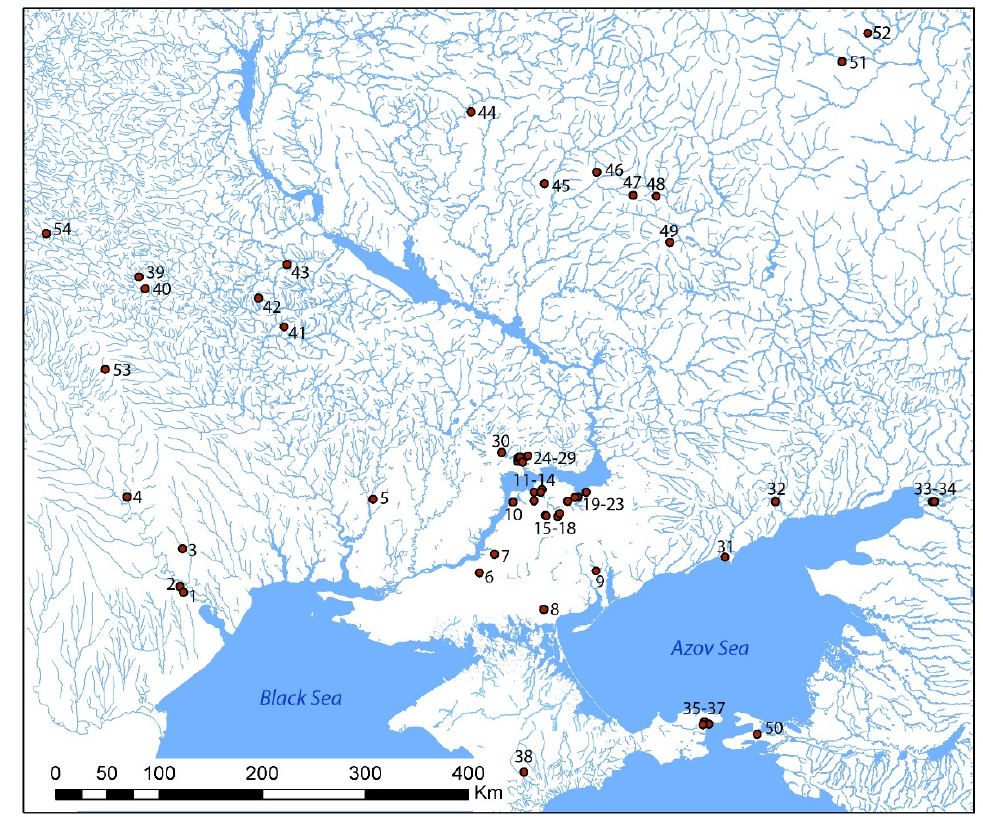
Figure 12. Location of greaves in burials of Scythian times in the northern Black Sea